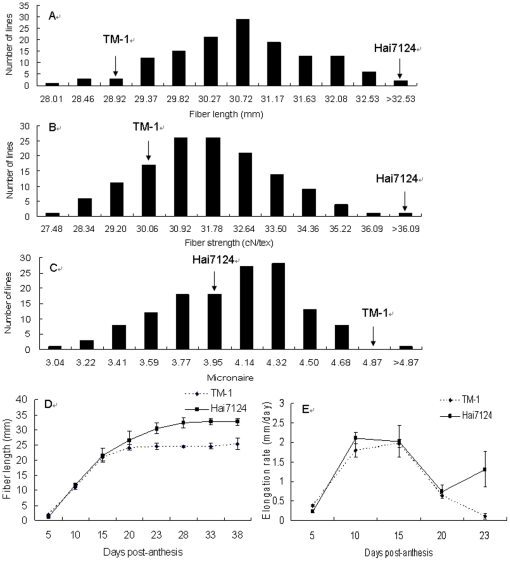
The frequency distribution of fiber quality traits and dynamic change of fiber length during development.The mean values of fiber length (a), strength (b) and micronaire (c) obtained from four-year data of BC1S1 family lines. Average phenotypic values for parents (G. hirsutum acc. TM-1 and G. barbadense cv. Hai7124) are indicated by arrows. (x-axis: phenotypic value; y-axis: number of lines). (d). TM-1 and Hai7124 cotton fiber length at different development stages; (e). TM-1 and Hai7124 cotton fiber elongation rate (increasing length per day) at different development stages. Error bars are the standard deviation calculated with seeds from six biological replicates.